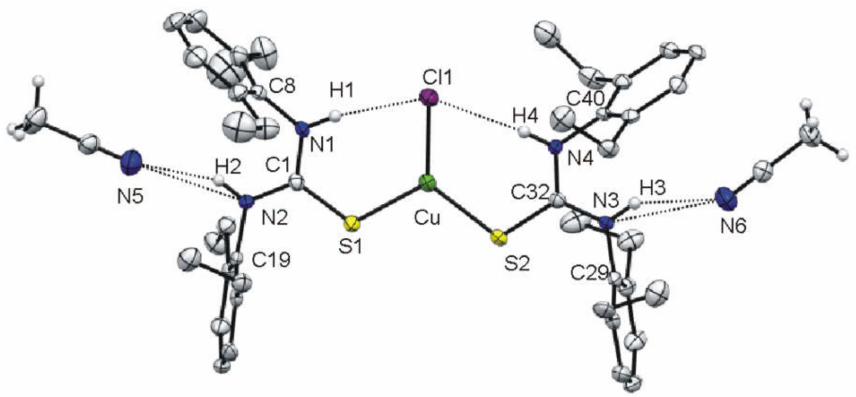
Figure 3. Molecular structure of 1a (ellipsoids correspond to the 50% probability level). All hydrogen atoms, except those of N-H and CH 3 hydrogens of acetonitrile, have been deleted for clarity. Selected bond lengths (Å) and angles ( ◦ ): Cu1–S1 2.2176(9), Cu1–Cl1 2.2440(9), Cu1–S2 2.2180(9), S1–C11